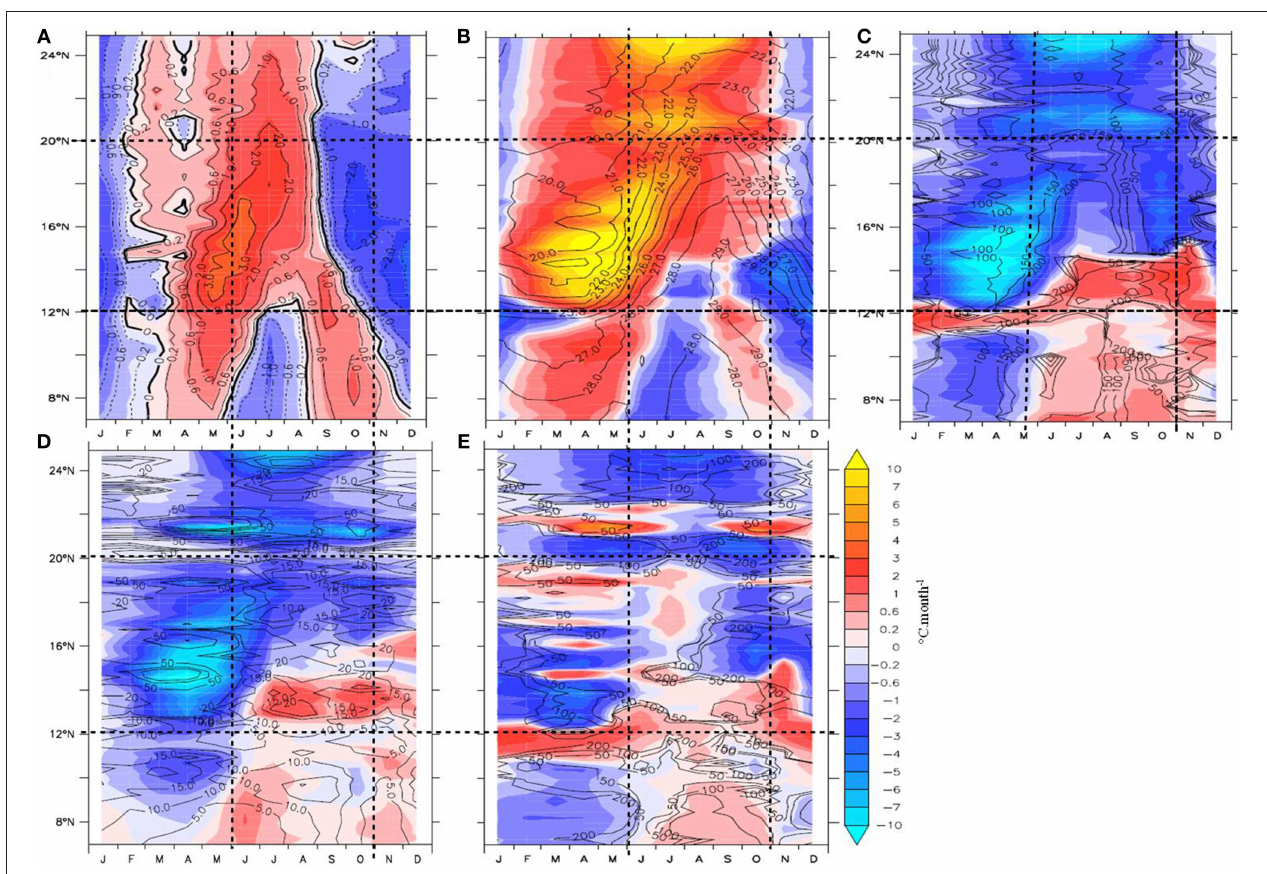
FIGURE 13 | Latitude-time Hovmöller plots along the coastal region (averaged from the coast to 18 ◦ W) of the mean seasonal cycles. (A) model total temperature trend (shading and contours, ◦ C.month − 1 ), (B) air-sea heat vertical process (shading), and SST model (contours, ◦ C), (C) total oceanic trend (shading, ◦ C.month − 1 ) and ratio of net air-sea flux effect over ocean effect (contours, %), (D) trend associated with vertical processes (shading, ◦ C.month − 1 ) and maximum vertical velocities between surface and thermocline (contours, m.month − 1 ) and (E) horizontal processes (shading, ◦ C.month − 1 ) and ratio of horizontal processes over vertical processes (contours,